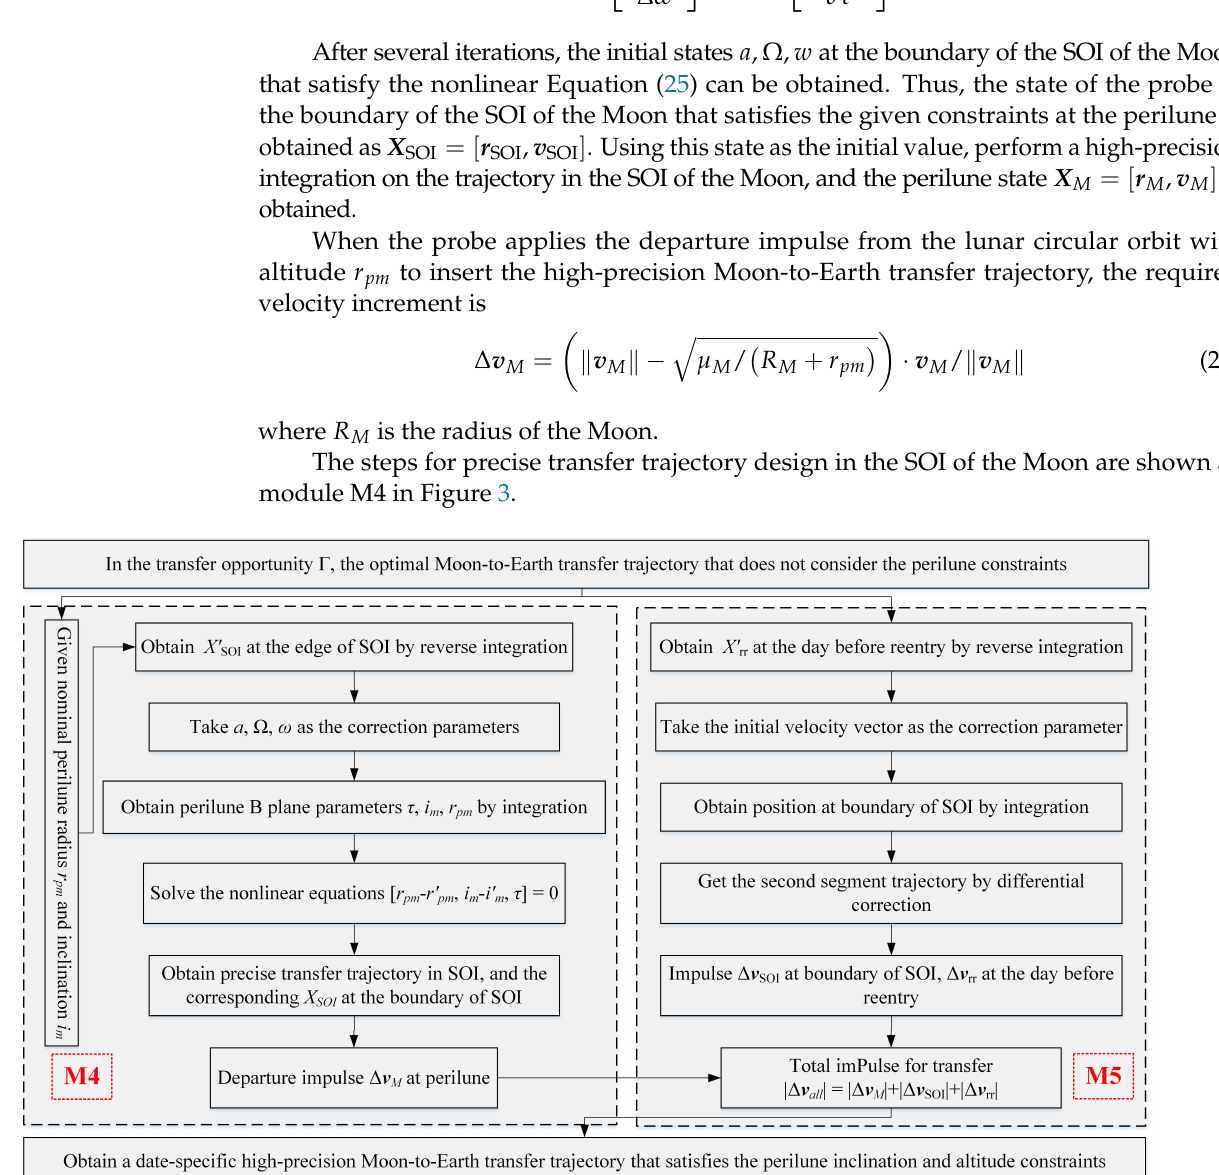
Figure 3. Flowchart for precise transfer trajectory design. M4 shows the procedures for precise trajectory design in SOI of the Moon; M5 presents the precise trajectory design out of SOI of the